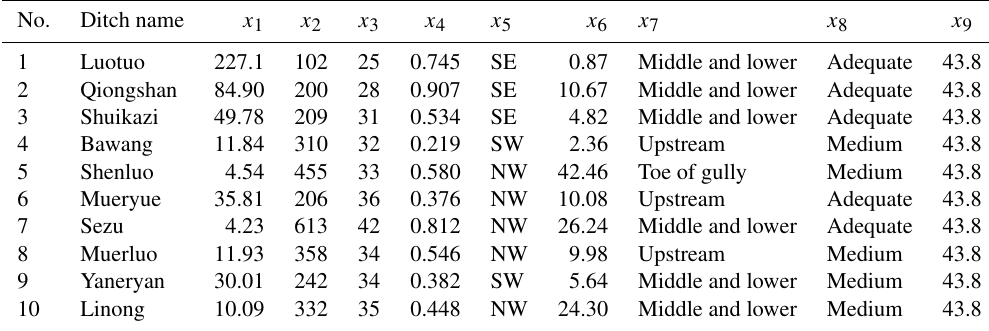
Table 9. Sample data from Kaka area upstream of the Dadu River.